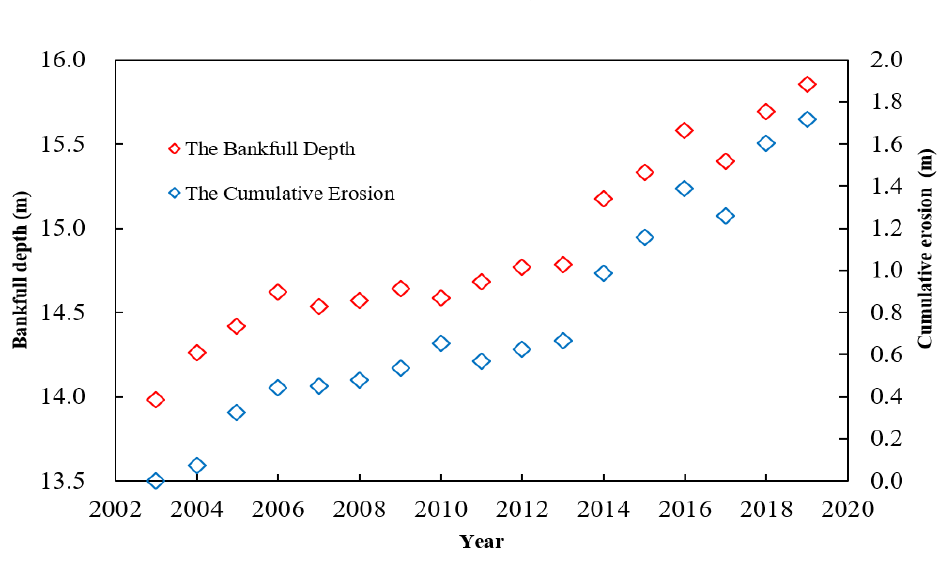
Figure 3. Temporal variations in the flow and sediment regimes at Hankou Hydrological Station.